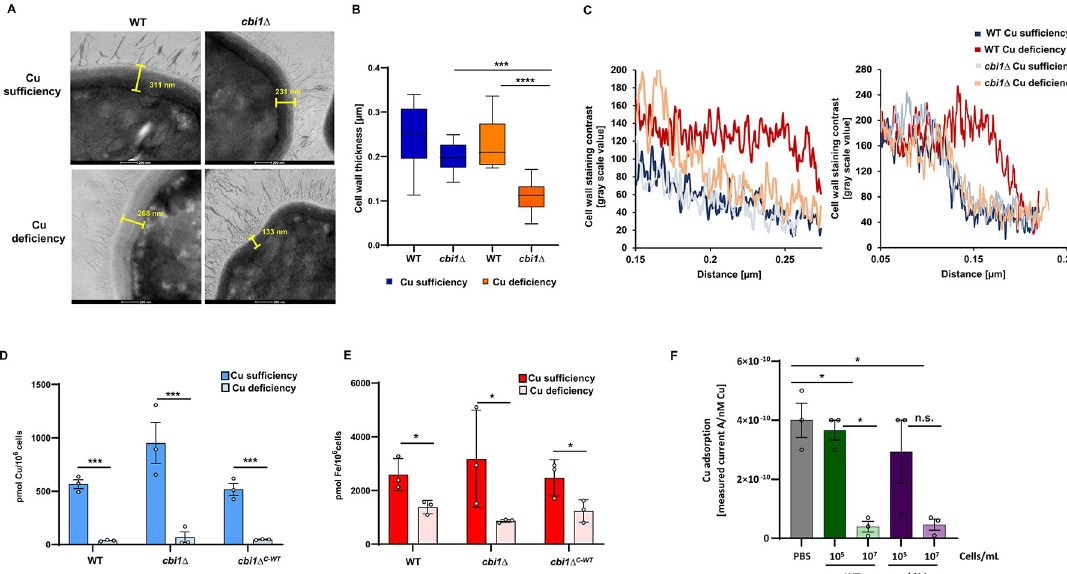
Fig 3. Copper deficient cbi1 Δ cells show a distinct cell wall electron density pattern, which is not due to overall difference in cell associated copper levels or copper adsorption ability. Transmission electron microscopy (TEM) images of copper sufficient or deficient WT and cbi1 Δ cells. The WT and cbi1 Δ strains were incubated in YPD medium supplemented with 10 μ M CuSO 4 (Cu sufficiency) or with 250 μ M BCS (Cu deficiency) for 24h at 30˚C. (A) Representative images with representative cell wall thickness indicated (29000 x magnification). (B) Quantification of cell wall thickness. Measurements were performed using the ImageJ/Fiji measurement tool: Cu sufficiency-WT 10 cells, Cu sufficiency- cbi1 Δ 8 cells, Cu deficiency-WT 11 cells and Cu deficiency- cbi1 Δ 14 cells. A 1-way ANOVA was performed using GraphPad Prism from log transformed data. (C) Quantification of the cell wall staining intensity. Presented is the analysis of two sets of TEM images. The gray value was measured with ImageJ/Fiji and plotted against the distance along the cell wall from the inner cell surface. (D-E) ICP-MS based metal quantification of cell associated copper (D) and Iron (E) in pg metal per 10 6 cells. Indicated strains were grown in identical growth conditions to the TEM experiment. Presented is the average +/- SEM from 3 biological replicates. A 2-way ANOVA was performed from log transformed data using GraphPad Prism. (F) ASV analysis of copper adsorption by Cn cells. Indicated strains were grown under Cu starvation (YPD + 250 μ M BCS) for 24h at 30˚C. Copper was titrated in 250 nM steps into 20 mL cell suspension of indicated concentration or PBS (= control). The peak height of the resulting current in each titration step was measured using the NOVA software (Autolab) and plotted against copper concentration. Linear regression was performed to determine slope of each titration experiment. Shown is the mean +/- SEM of the slopes determined by 3 independednt titration experiments. A ONE-Way ANOVA was performed from log transformed data.